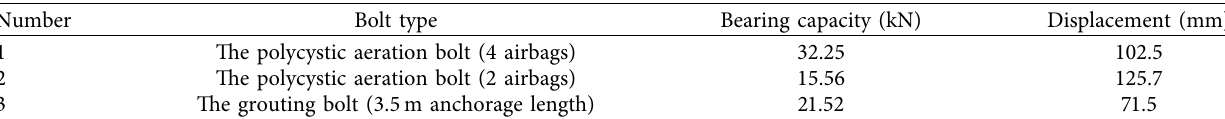
Table 4: The bearing capacity and displacement of